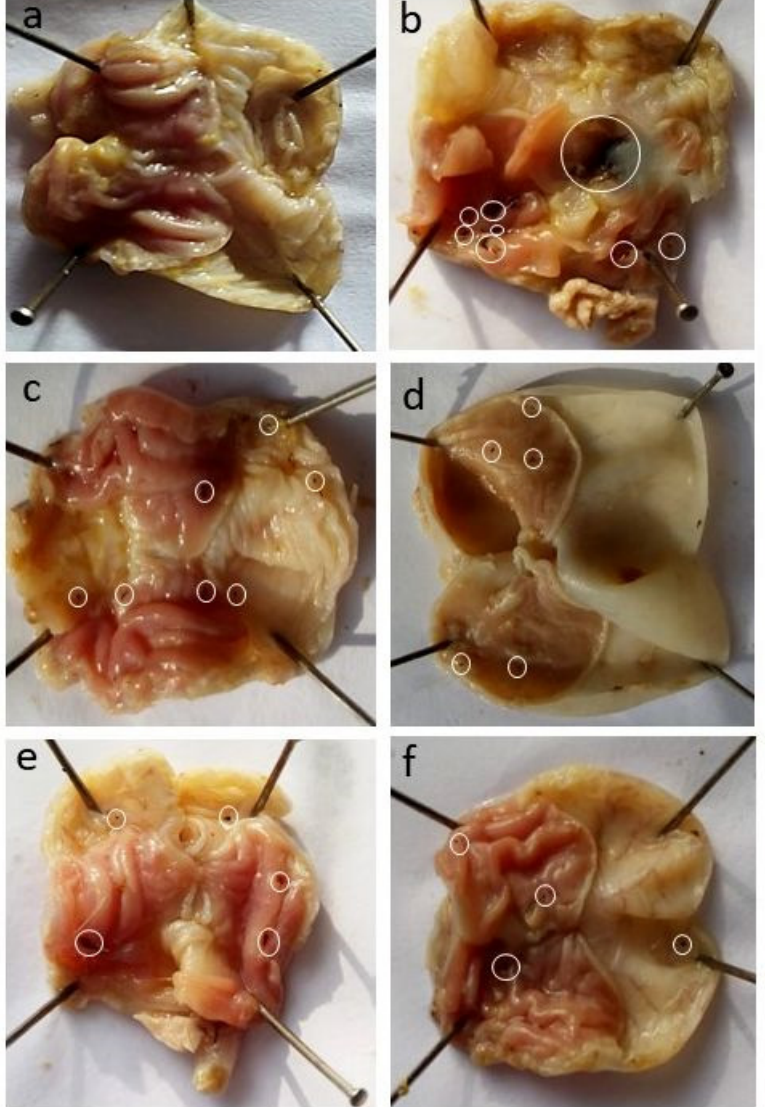
Figure 8. Macroscopic lesion in stomach mucosa of rats: ( a ) control, ( b ) flurbiprofen, ( c ) S1, ( d ) S6, ( e ) S7, and ( f ) S12.